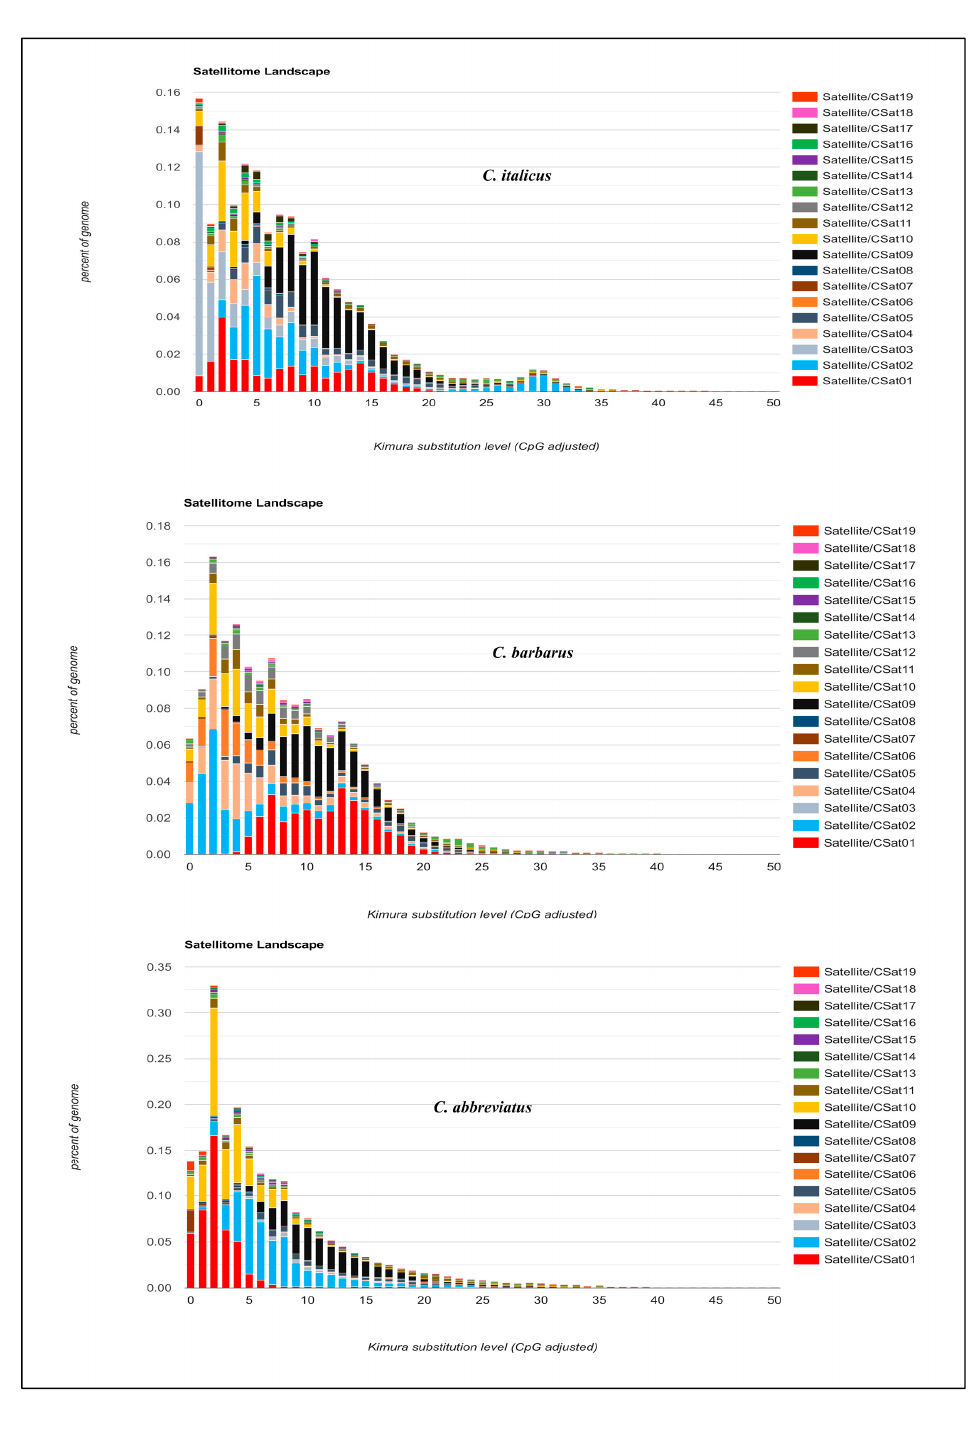
Figure 3. Satellitome landscape graphs represent genome coverage/genome proportion for each satDNA family along the Y -axis in the different genomes analyzed and Kimura genetic distances to their corresponding consensus sequence along the X -axis (K2P ranged from